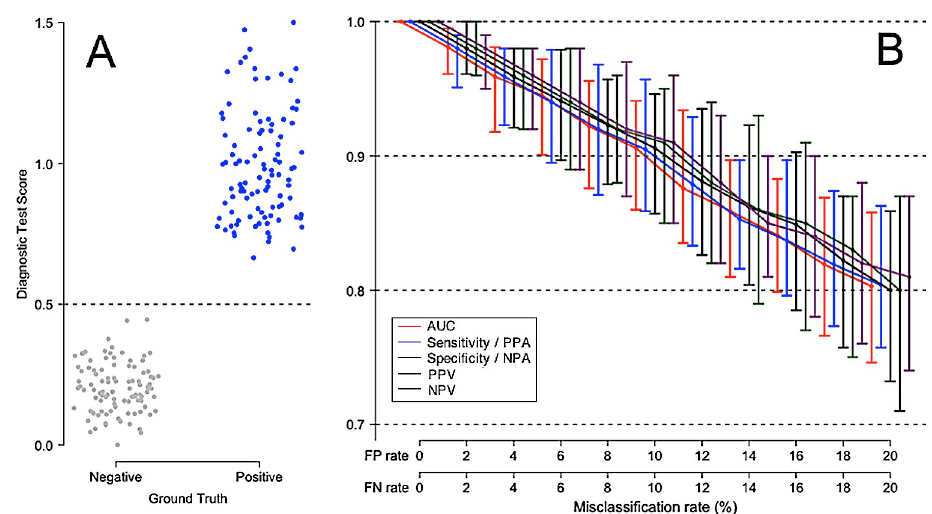
Fig 3. Degradation of apparent performance of a perfect diagnostic test, as a function of error in the comparator. In this scenario, Ground Truth positive patients and Ground Truth negative patients are equally likely to be misclassified by the comparator. (A) Comparator with no classification error, perfectly representing the Ground Truth for 100 negative patients and 100 positive patients. (B) Apparent performance of diagnostic test, as a function of the misclassification rate of the comparator. The error bars describe 95% empirical confidence intervals about medians, computed over 100 simulation cycles. True test performance is indicated when the FP and FN rates are each 0%. The terms Sensitivity and Specificity are appropriate when there is no misclassification in the comparator (FP rate = FN rate = 0%). The terms Positive Percent Agreement (PPA) and Negative Percent Agreement (NPA) should be used in place of Sensitivity and Specificity, respectively, when the comparator is known to contain uncertainty.